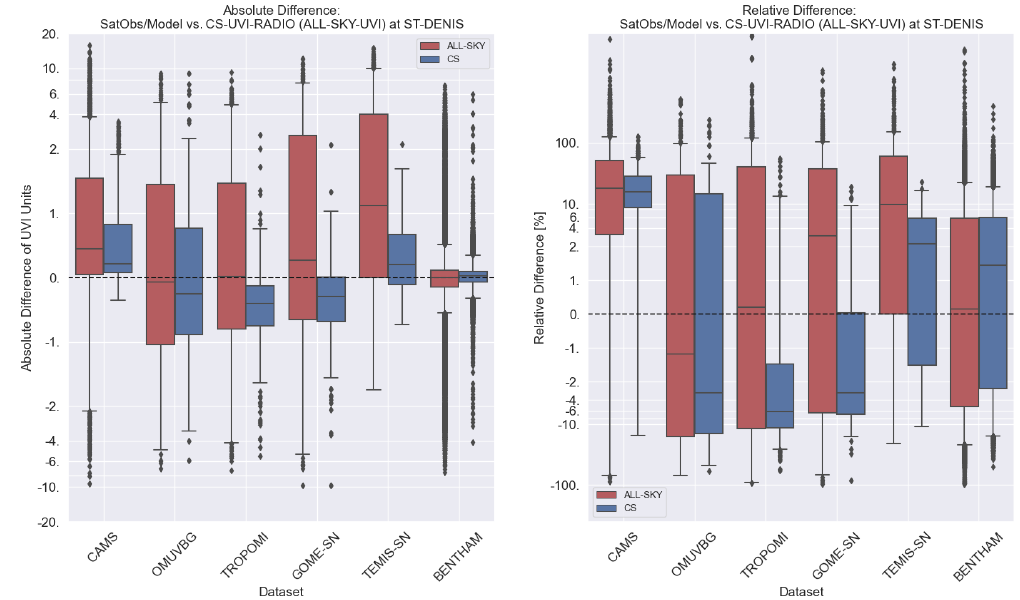
Figure 4. Boxplot of differences between UVI-RADIO and satellite/model estimates at Saint-Denis.